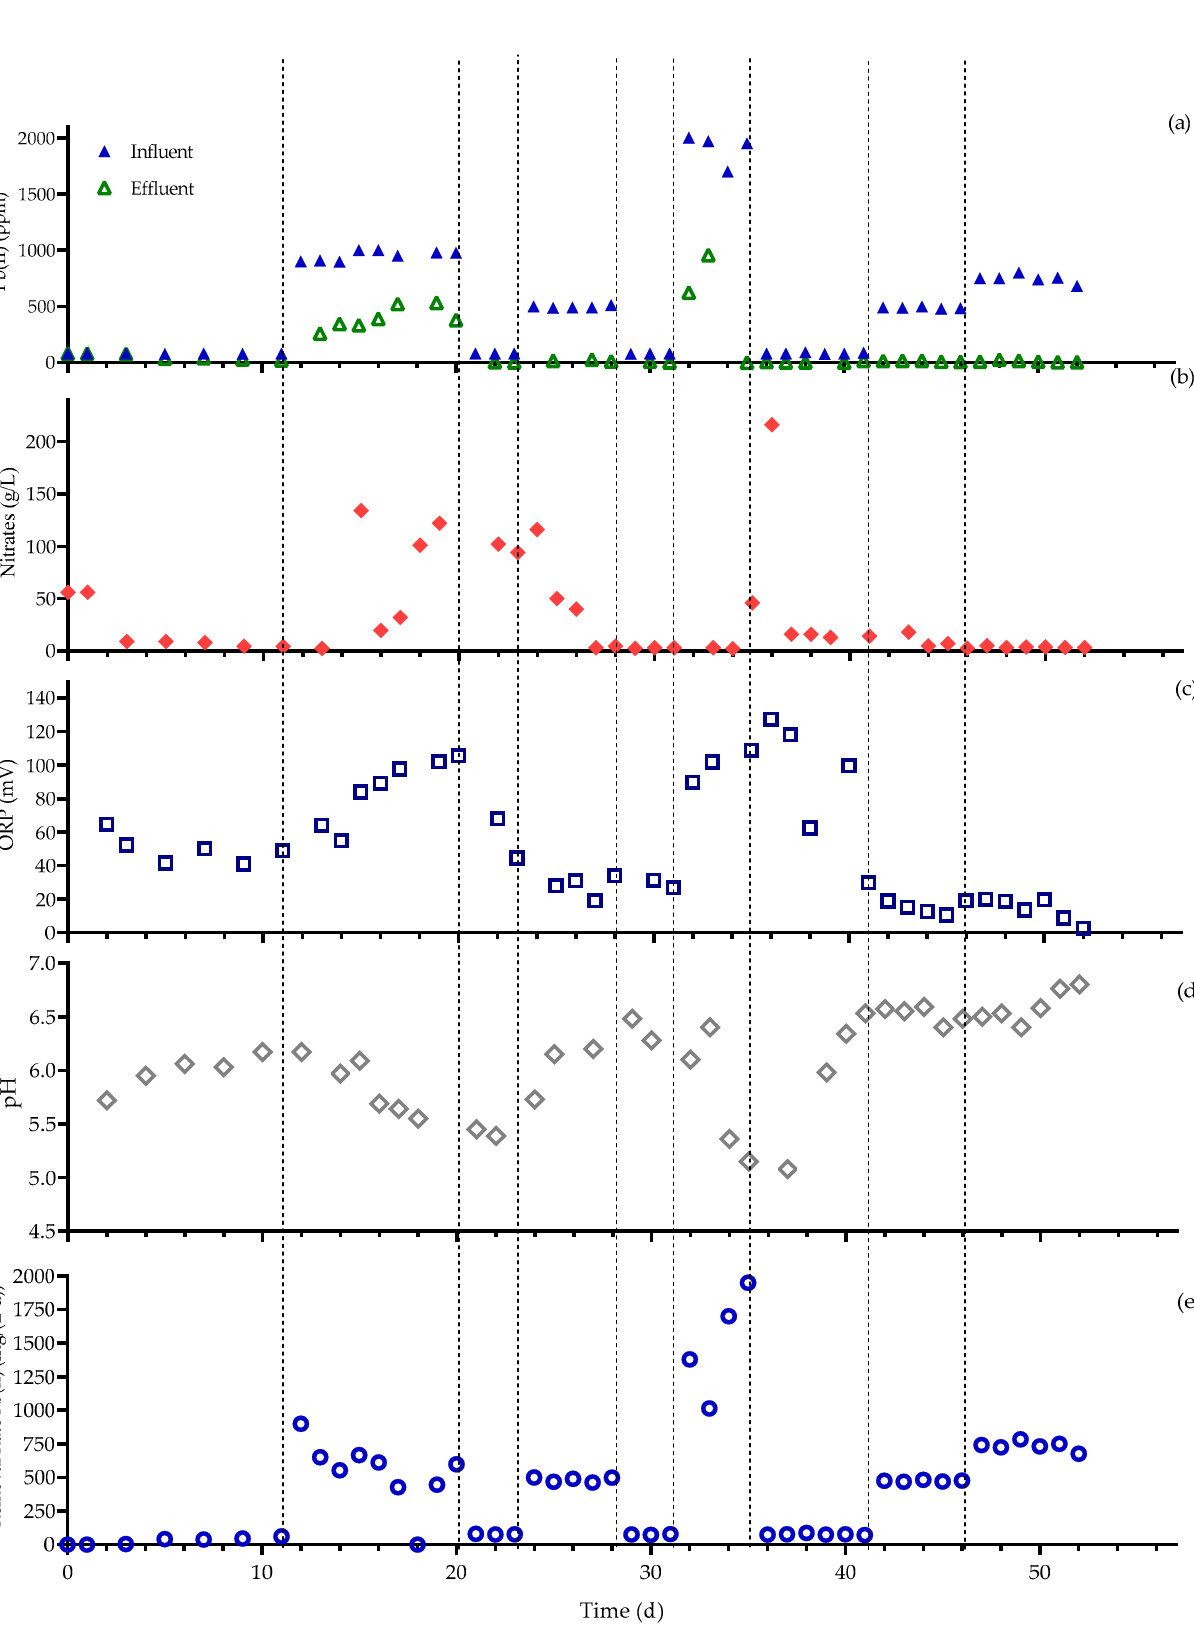
Figure 5. The lead level ( a ), nitrate measurements ( b ), ORP ( c ), pH ( d ) and Pb(II) removal rate ( e ) over time for run 3b.